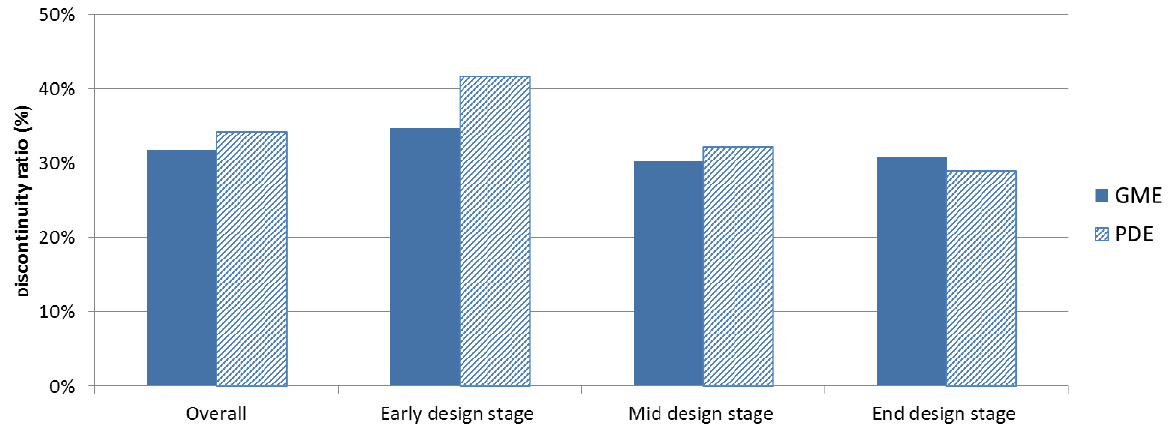
Figure 9. Discontinuity ratio comparison of the PDE vs. GME at different design stages.